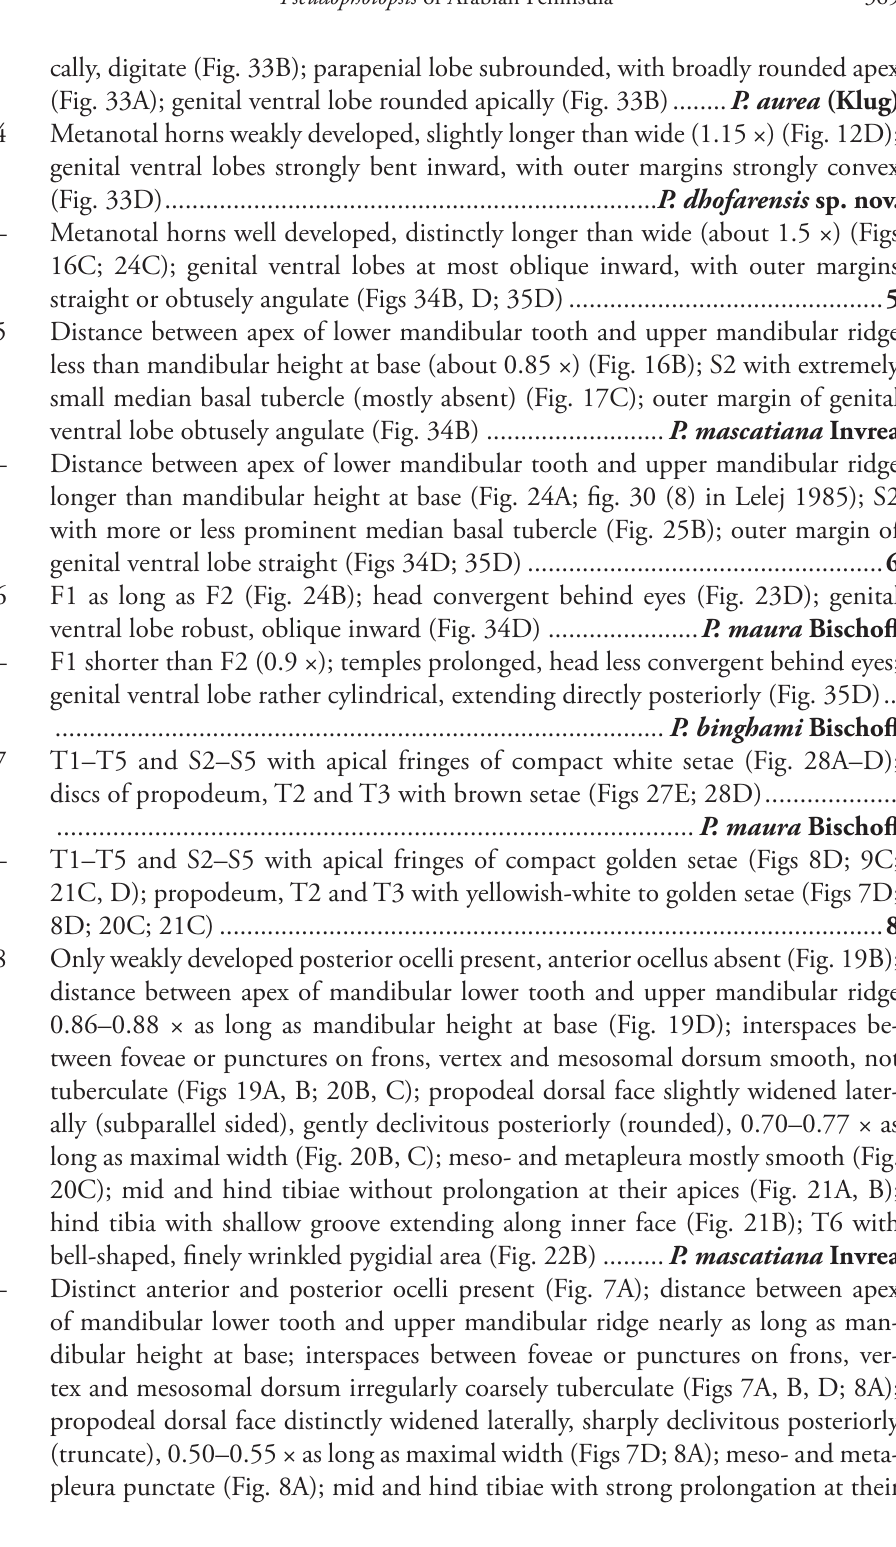
cally, digitate (Fig. 33B); parapenial lobe subrounded, with broadly rounded apex (Fig. 33A); genital ventral lobe rounded apically (Fig. 33B) ........ P. aurea (Klug) 4 Metanotal horns weakly developed, slightly longer than wide (1.15 ×) (Fig. 12D); genital ventral lobes strongly bent inward, with outer margins strongly convex (Fig. 33D) ........................................................................ P. dhofarensis sp. nov. – Metanotal horns well developed, distinctly longer than wide (about 1.5 ×) (Figs 16C; 24C); genital ventral lobes at most oblique inward, with outer margins straight or obtusely angulate (Figs 34B, D; 35D) .............................................. 5 5 Distance between apex of lower mandibular tooth and upper mandibular ridge less than mandibular height at base (about 0.85 ×) (Fig. 16B); S2 with extremely small median basal tubercle (mostly absent) (Fig. 17C); outer margin of genital ventral lobe obtusely angulate (Fig. 34B) .......................... P. mascatiana Invrea – Distance between apex of lower mandibular tooth and upper mandibular ridge longer than mandibular height at base (Fig. 24A; fig. 30 (8) in Lelej 1985); S2 with more or less prominent median basal tubercle (Fig. 25B); outer margin of genital ventral lobe straight (Figs 34D; 35D) .................................................... 6 F1 as long as F2 (Fig. 24B); head convergent behind eyes (Fig. 23D); genital ventral lobe robust, oblique inward (Fig. 34D) ...................... P. maura Bischoff – F1 shorter than F2 (0.9 ×); temples prolonged, head less convergent behind eyes; genital ventral lobe rather cylindrical, extending directly posteriorly (Fig. 35D) .. ......................................................................................... P. binghami Bischoff 7 T1–T5 and S2–S5 with apical fringes of compact white setae (Fig. 28A–D); discs of propodeum, T2 and T3 with brown setae (Figs 27E; 28D) ................... – T1–T5 and S2–S5 with apical fringes of compact golden setae (Figs 8D; 9C; 21C, D); propodeum, T2 and T3 with yellowish-white to golden setae (Figs 7D; 8D; 20C; 21C) ................................................................................................. 8 Only weakly developed posterior ocelli present, anterior ocellus absent (Fig. 19B); distance between apex of mandibular lower tooth and upper mandibular ridge 0.86–0.88 × as long as mandibular height at base (Fig. 19D); interspaces be- tween foveae or punctures on frons, vertex and mesosomal dorsum smooth, not tuberculate (Figs 19A, B; 20B, C); propodeal dorsal face slightly widened later- ally (subparallel sided), gently declivitous posteriorly (rounded), 0.70–0.77 × as long as maximal width (Fig. 20B, C); meso- and metapleura mostly smooth (Fig. 20C); mid and hind tibiae without prolongation at their apices (Fig. 21A, B); hind tibia with shallow groove extending along inner face (Fig. 21B); T6 with bell-shaped, finely wrinkled pygidial area (Fig. 22B) ......... P. mascatiana Invrea – Distinct anterior and posterior ocelli present (Fig. 7A); distance between apex of mandibular lower tooth and upper mandibular ridge nearly as long as man- dibular height at base; interspaces between foveae or punctures on frons, ver- tex and mesosomal dorsum irregularly coarsely tuberculate (Figs 7A, B, D; 8A); propodeal dorsal face distinctly widened laterally, sharply declivitous posteriorly (truncate), 0.50–0.55 × as long as maximal width (Figs 7D; 8A); meso- and meta- pleura punctate (Fig. 8A); mid and hind tibiae with strong prolongation at